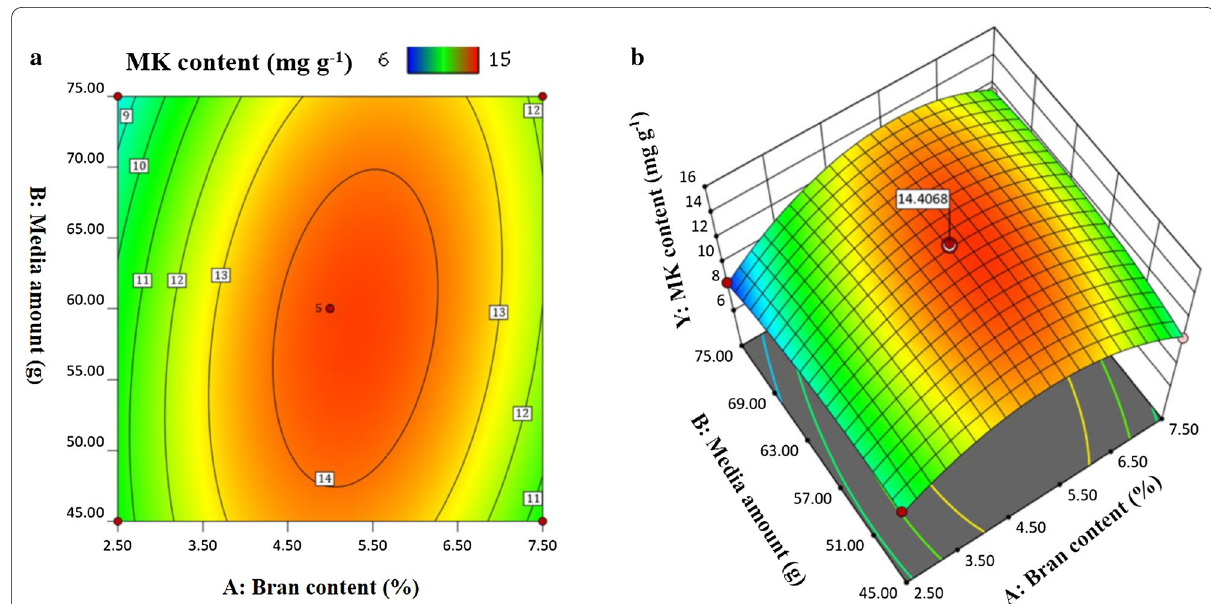
Fig. 5 Interaction between bran content and media amount at a fixed initial water of 50%: (a) Contour plot, (b) 3D Surface plot